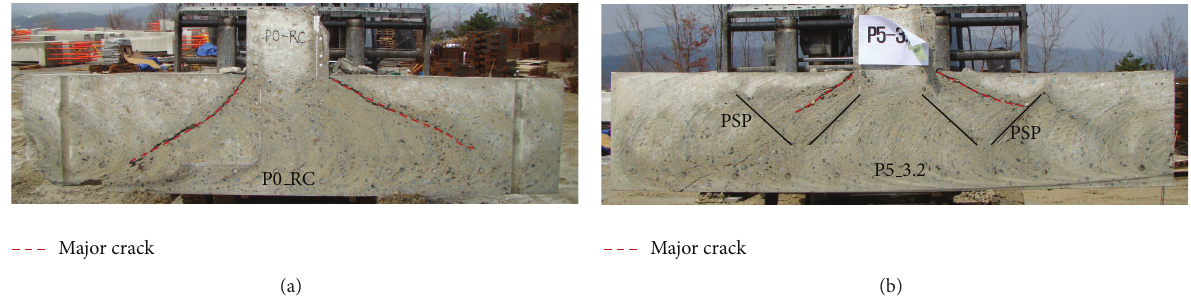
Figure 7: Crack pattern in the middle plane of the test specimen: (a) P0 RC and (b) P5 3.2.